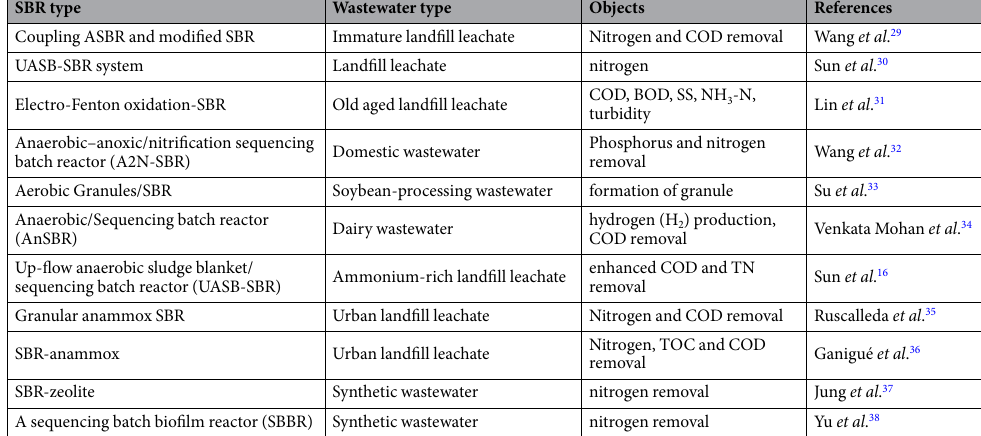
Table 1. Various operations and combination of SBRs for wastewater